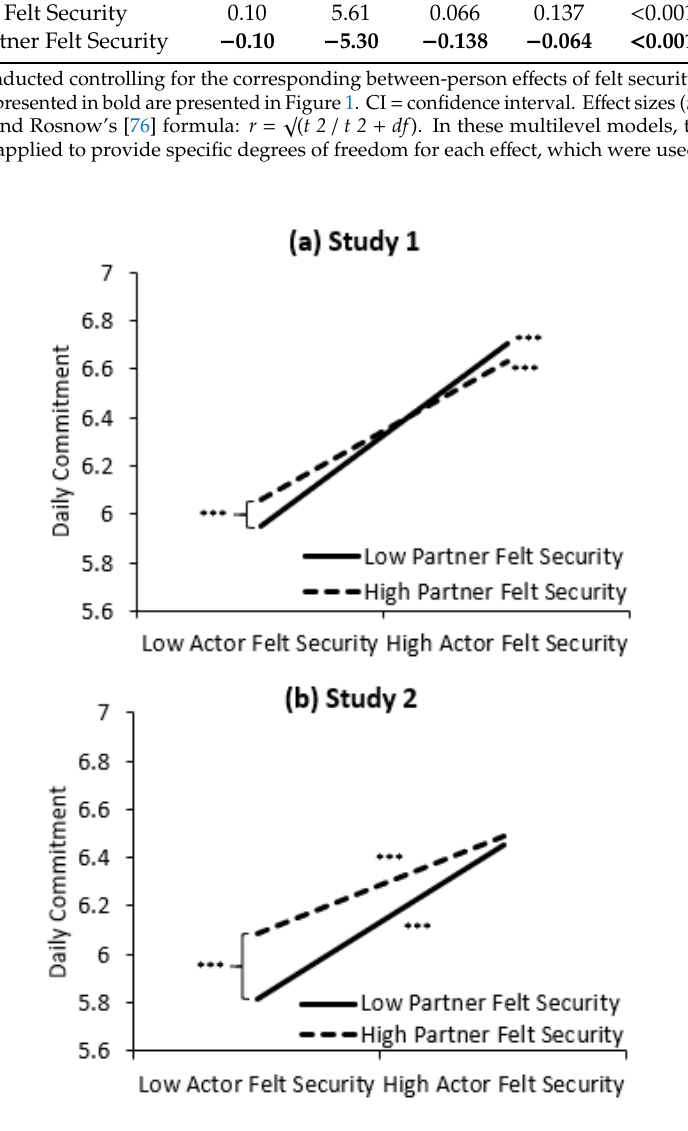
simple effects of the slopes and contrasts are marked *** p ≤ .001.